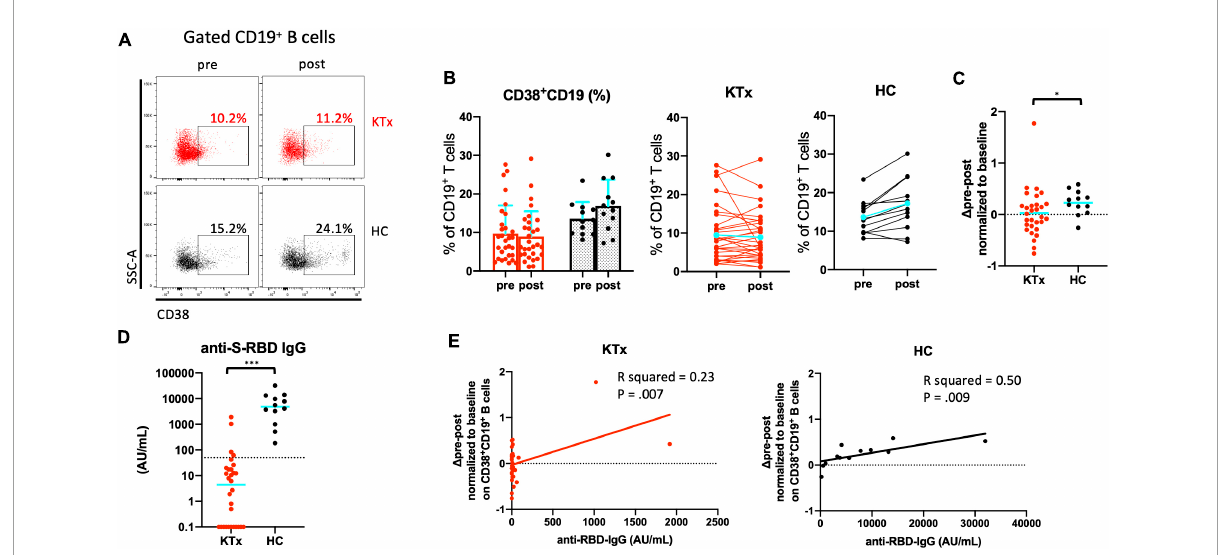
FIGURE6 Activated CD19 + B cells increased after SARS-CoV-2 mRNA vaccination in HCs. (A) Representative gating strategies and scatter plots of activated CD38 + cells among CD19 + B cells in the two groups pre- and post-vaccination. (B) Comparison of the proportion and change in proportion of CD38 + CD19 + B cells in KTx recipients (left) and HCs (right) as measured by flow cytometry. (C) Normalized increase in CD38 + CD19 + B cells between pre- and post-vaccination. (D) Serologic S-RBD IgG antibody response against SARS-CoV-2 at 30 days after D2 vaccination. (E) Scatter plot of anti-S-RBD IgG values and normalized increase in CD38 + CD19 + B cells by flow cytometric analysis. Data were obtained from 42 samples (30 in KTx group and 12 on HC group), and a moderate correlation was found in HC group. Bar plots depict mean ± SD. Blue lines and bars represent means. Data were analyzed using the Mann-Whitney U test (* P < 0.05, *** P < 0.001).